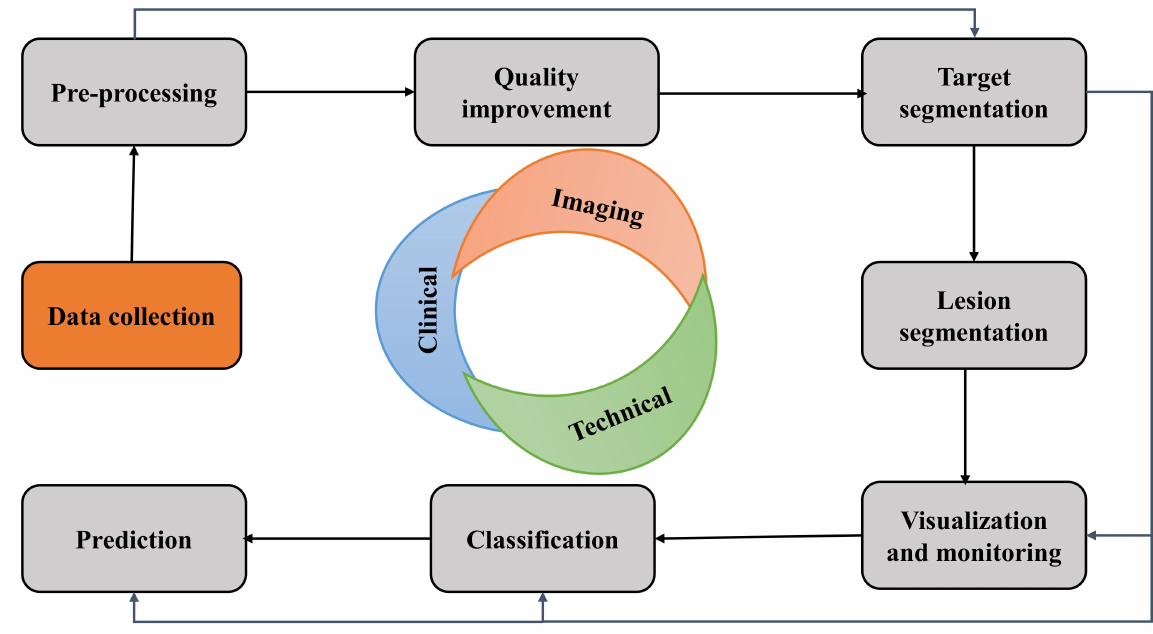
Figure 7. Potential clinical uses of Computer Vision in medical imaging techniques and the corre- sponding possible